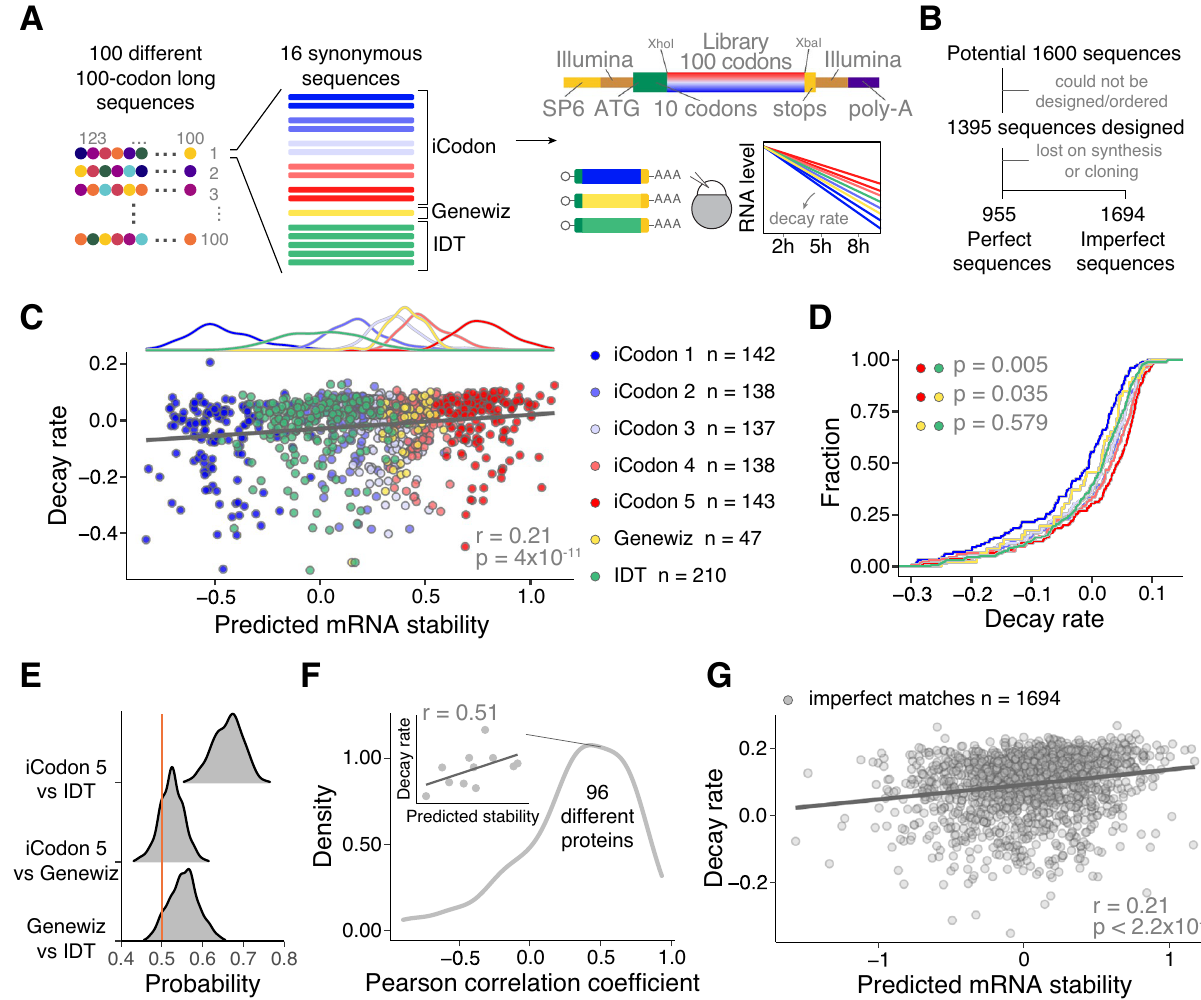
Figure 2. iCodon predicts the stability of thousands of injected mRNAs into zebrafish embryos. ( A ) Schematic of the reporter library. For 100 different 100-codons long proteins, 16 different coding sequences differing only in synonymous codons were designed. For each protein, 10 sequences were designed by iCodon in 5 bins with increasing predicted stability, 5 sequences by the method used by IDT and one for the Genewiz’s method. The sequences were ordered in bulk and cloned into the vector by restriction cloning with XhoI and XbaI, to generate transcripts sharing the same 5 ′ and 3 ′ UTR containing Illumina adapters (copper) and 27 nt within the translation start site (green). In vitro transcribed mRNAs (SP6 promoter in yellow) were injected into 1-cell stage zebrafish embryos. Reporter mRNA library is analyzed at 2, 5, and 8 h post-injection. ( B ) Pipeline showing the steps to identify the designed reporter sequences (perfect) as well as non-designed sequences (imperfect). ( C ) Top: histogram displaying the frequency of predicted mRNA stability for each group of sequences. Bottom: Scatter plot showing a positive correlation between predicted mRNA stability and decay rate of injected mRNA reporters in zebrafish embryos (n = 955, r = 0.21, p = 4 × 10 –11 , Spearman correlation test). The colors indicate the method used to design the coding sequences. ( D ) Cumulative distributions of the decay rate of injected mRNAs reporters into zebrafish embryos designed with different methods (indicated by colors). iCodon 5 versus IDT p = 0.005, iCodon 5 versus Genewiz p = 0.035, and Genewiz versus IDT p = 0.579, unpaired, one-tailed t-test). ( E ) Histogram showing the probability to design the most stable mRNA for the 96 encoded proteins between the indicated methods. Orange line indicates a probability of 0.5. ( F ) Histogram showing the distribution of the Pearson correlation coefficients between the predicted mRNA stability and decay rate of injected mRNA synonymous reporters per protein. Inset shows the correlation between the predicted mRNA stability and decay rate of injected mRNA synonymous reporters for one protein as an example. ( G ) Scatter plot showing a positive correlation between predicted mRNA stability and decay rate of injected mRNA reporters in zebrafish embryos that did not match perfectly with the designed sequences but were observed in at least 2 replicates of each time point and encode for a protein longer than 70 codons (n = 1694, r = 0.21, p < 2.2 × 10 –16 , Spearman correlation